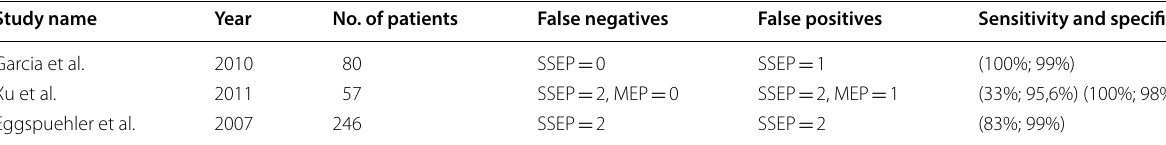
Table 4 False negatives and false positives of intraoperative